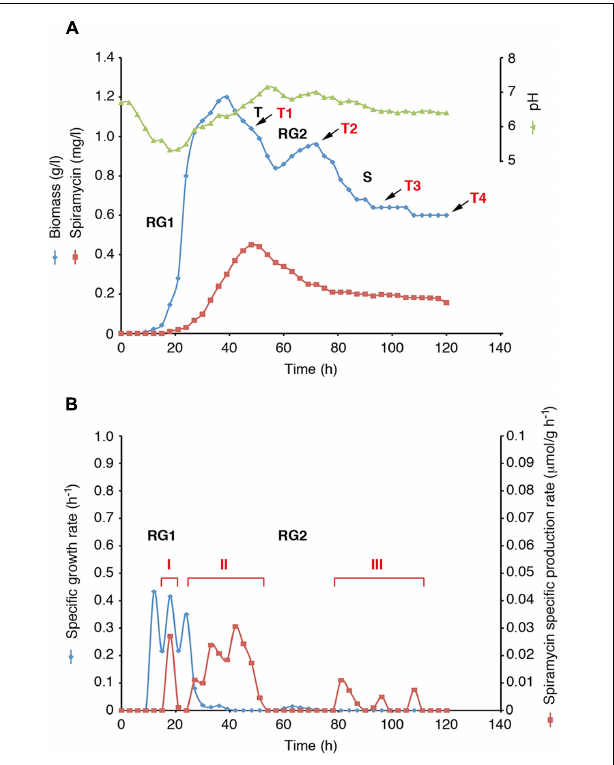
FIGURE 1 | Streptomyces ambofaciens ATCC 23877 growth curve and spiramycin production kinetics. (A) Biomass, pH and spiramycin production curves. Growth phases (RG1, T, RG2 and S) and the four sampling points for RNA-seq analysis is indicated (T1 to T4). (B) Growth rate and spiramycin specific productivity. Phases with high specific spiramycin production rates are shown (I, II,